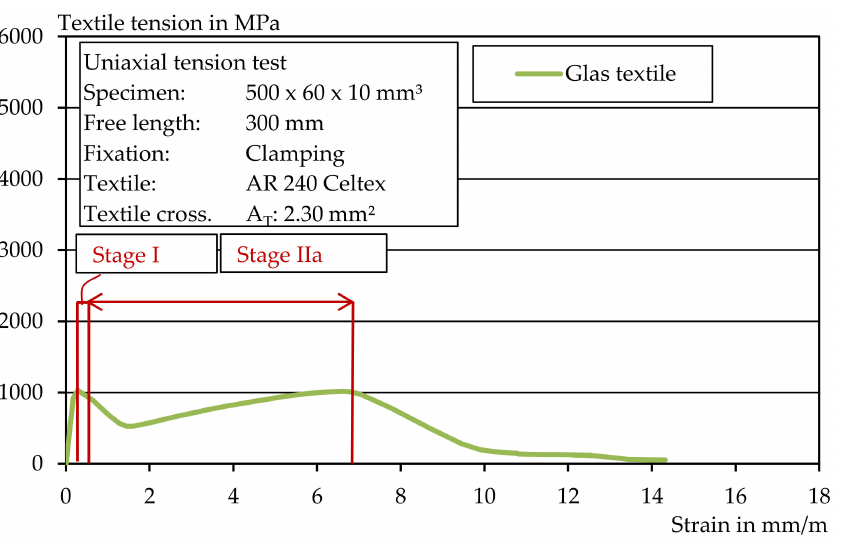
Figure 17. Stress–strain curve in a uniaxial tension test with glass